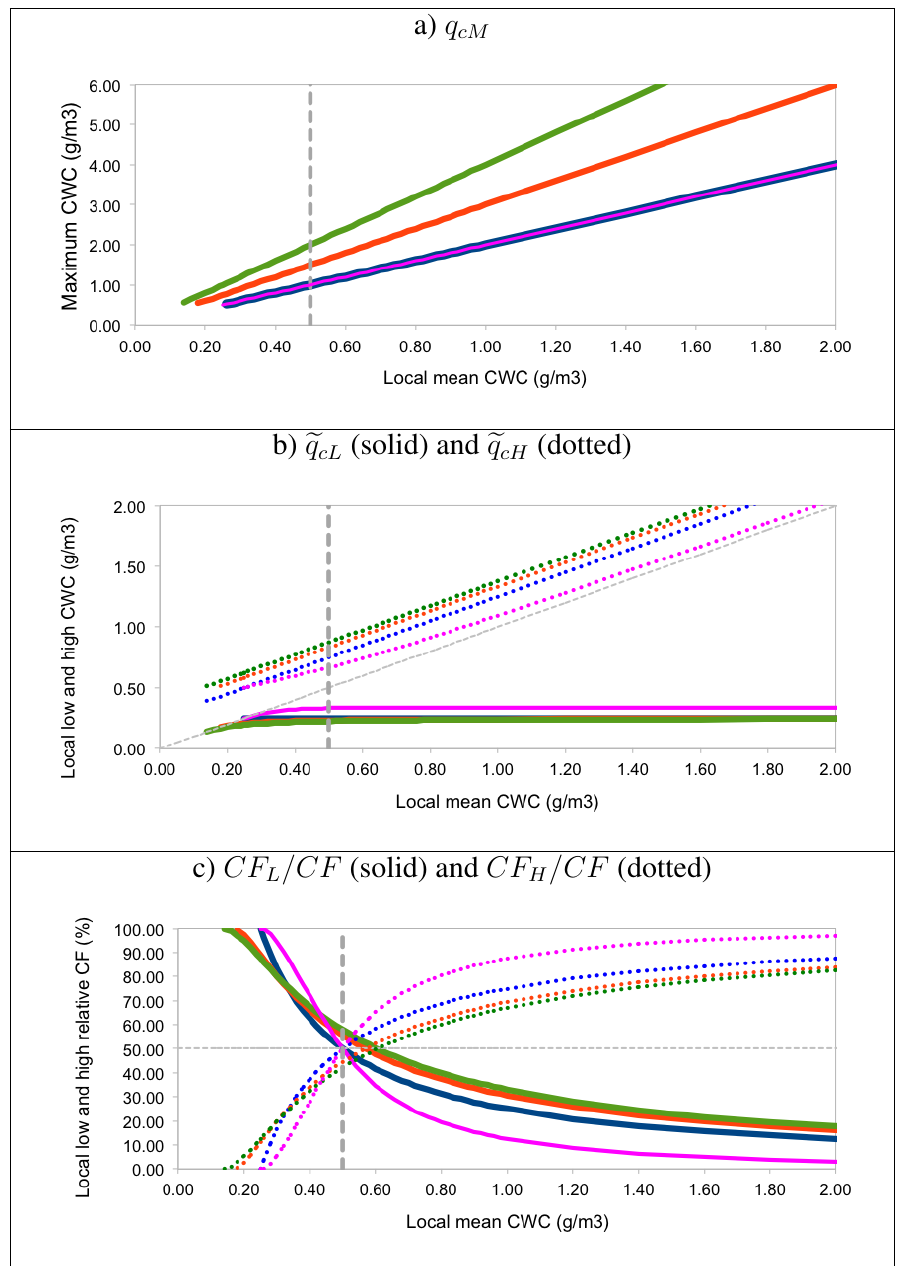
Fig. 2. Variations of (a) the maximum CWC ( q cM ), (b) the mean local low ( e q cL , solid lines) and high ( e q cH , dotted lines) CWC and (c) the relative cloud fractions in low CWC region (solid lines) and high regions (dotted lines) as a function of e q c . The four PDF forms are rectangular (blue), rectangular triangular (red), quadratic (green) and isosceles triangular (pink). A vertical dashed grey line is added at the autoconversion threshold. Note that two grey reference lines are added in (b) and (c) , and the blue line is overlapping the pink one in (a) .